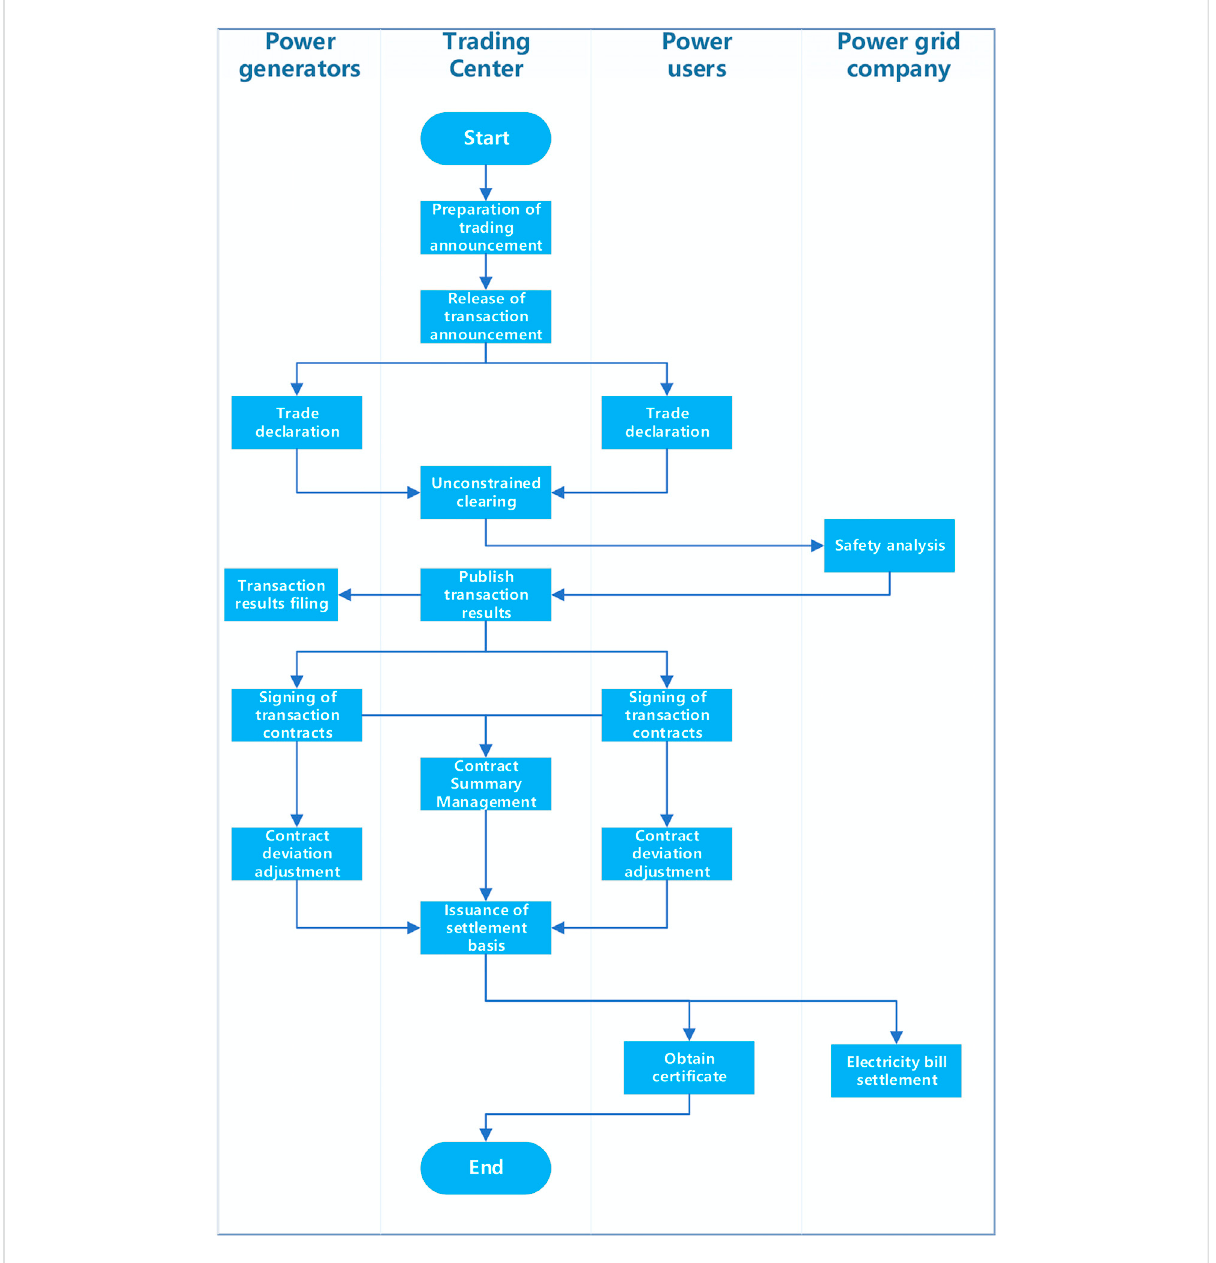
FIGURE 4 Process of market